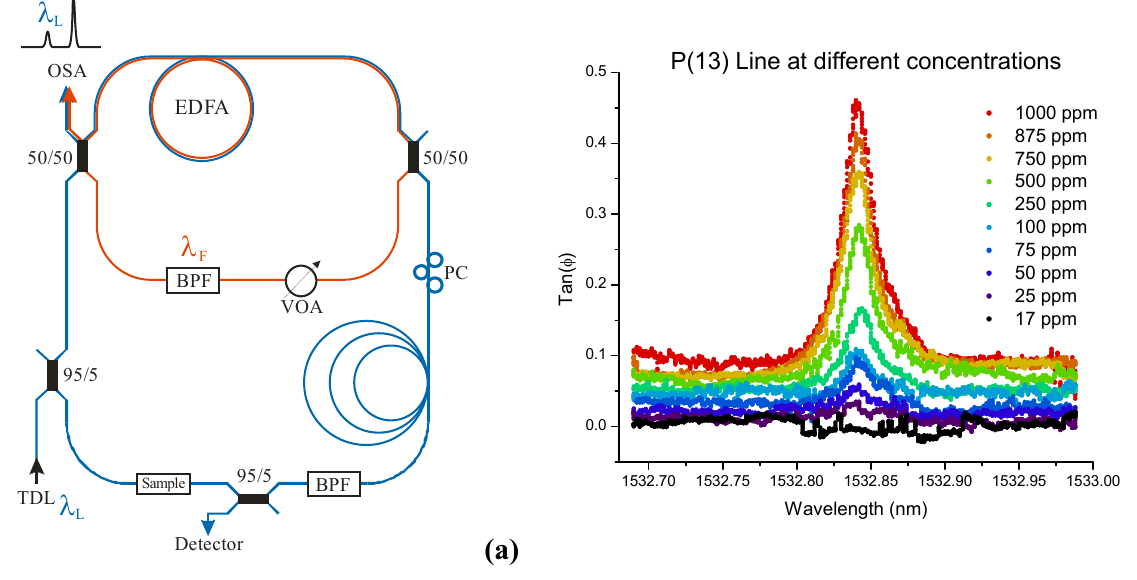
Figure 9. (a) Setup of the amplified cavity ring-down system using two fiber loops that share the same amplifier. The lasing inner loop stabilizes the gain, and the outer loop is used for the ring-down measurements. The advantage compared to the single-loop system is that the lasing wavelength and the wavelength for the spectroscopic measurement do not need to be near or at coincidence to produce ultra-long ring-down times. (b) Measurement of acetylene in helium; 1 bar total